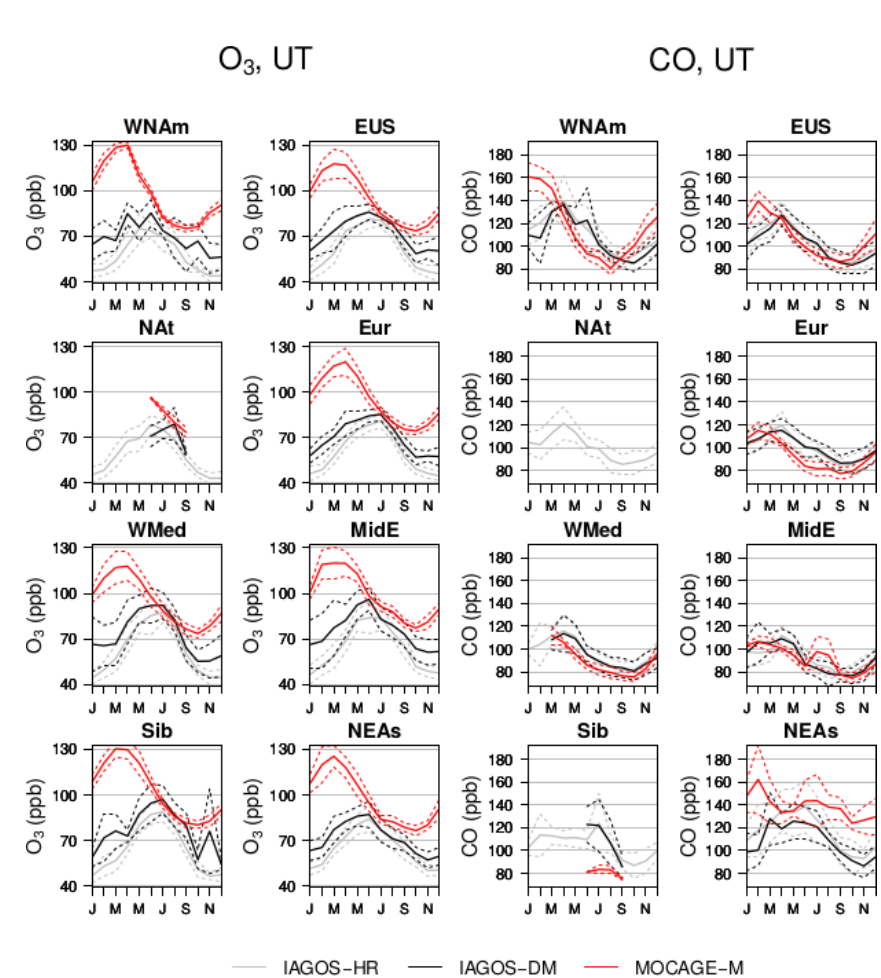
Figure C1. Mean seasonal cycles in the UT. O 3 is represented in the left two columns, and CO is in the right columns. Each graphic gathers the data from IAGOS-HR (grey), IAGOS-DM (black) and MOCAGE-M (red) in one given region. The solid lines illustrate the mean values, and the dashed lines show the uncertainties regarding the interannual variability. The mean values are shown only if they are derived from several monthly